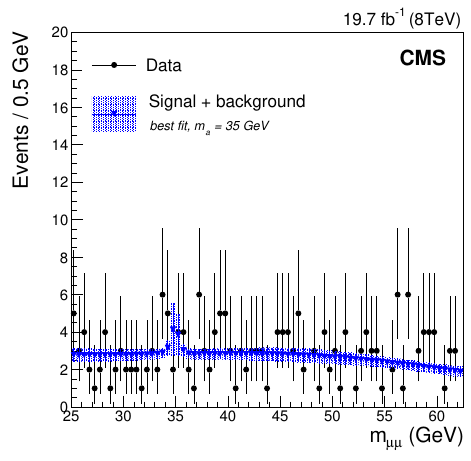
Figure 2 . The best (cid:12)t to the data for a signal-plus-background model with m a = 35 GeV, including pro(cid:12)ling of the uncertainties, in the search for h ! aa ! 2 (cid:22) 2b events.